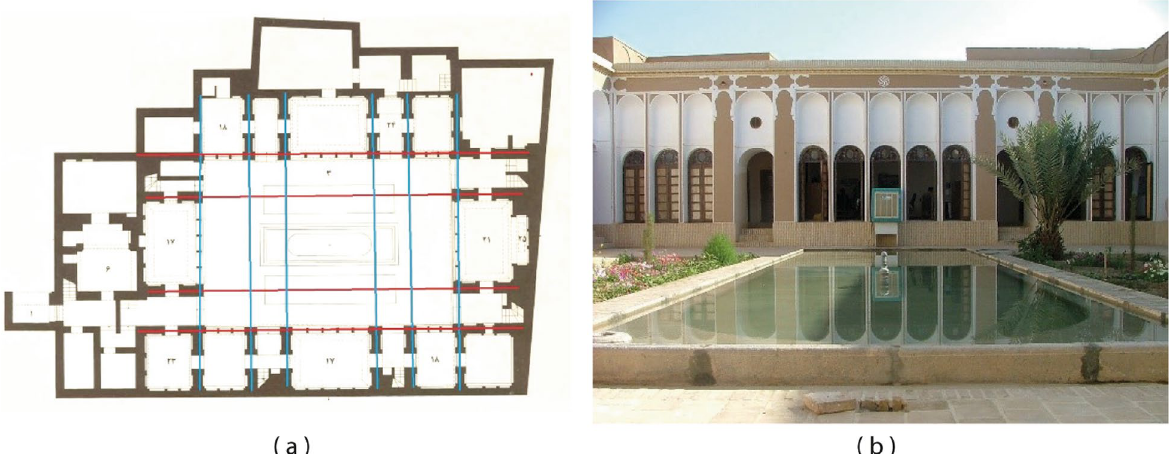
Fig. 6 The rather symmetric plan and elevation of Yazd adobe houses: ( a ) plan of the Shafipoor house (Source: Haji‑Qassemi and Khoei 2004) and ( b ) view of the Shokoohi house (Source: the